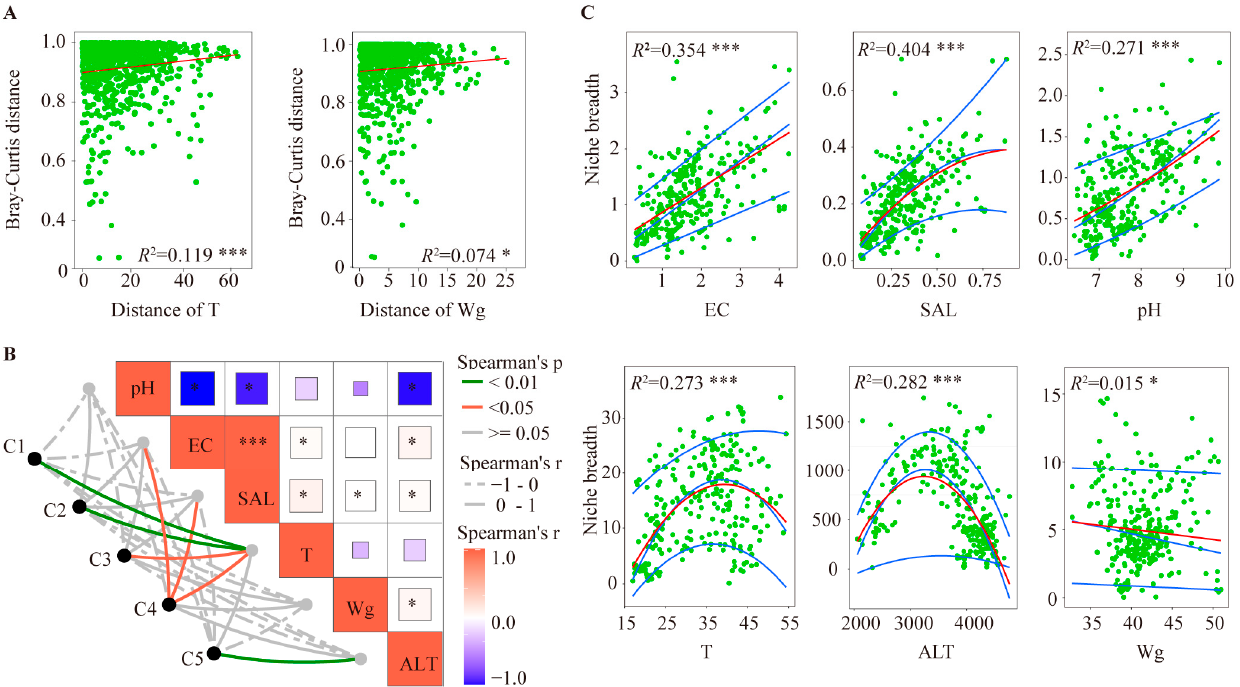
Figure 6. Relationship between environmental factors and protist community. ( A ) Relationship between Bray Curtis distance of protist communities and Euclidean distance of environmental factors. ( B ) Environmental drivers of protist communities, as evaluated by Mantel tests in the different clusters of hot springs. ( C ) Habitat niche breadth analysis of protists for each ASV along the gradient of environmental factors. Red lines indicate linear regression. Blue lines from bottom to top indicate the quantile regressions of 10%, 50%, and 90%, respectively. Notes: *** p ≤ 0.001; * p ≤ 0.05; other relationships are not statistically significant.